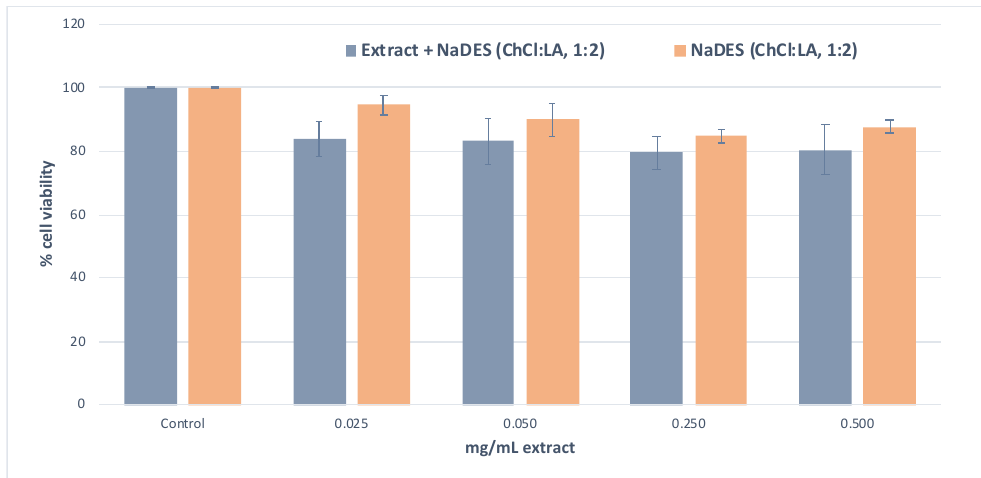
Figure 5. Effects of the extracts diluted with milli-Q water at four different concentrations (0.025–0.500 mg/mL), obtained under optimal extraction conditions (60% ultrasound amplitude, 18.8% water percentage, and 15 min extraction time) by UAE, with ChCl:LA (1:2) as the extraction solvent, from the extraction residue of mangosteen peel (blue color), as well as the effects of NaDES diluted with the same amount of milli-Q-water as the extracts (orange color) on cell viability in HeLA cells.